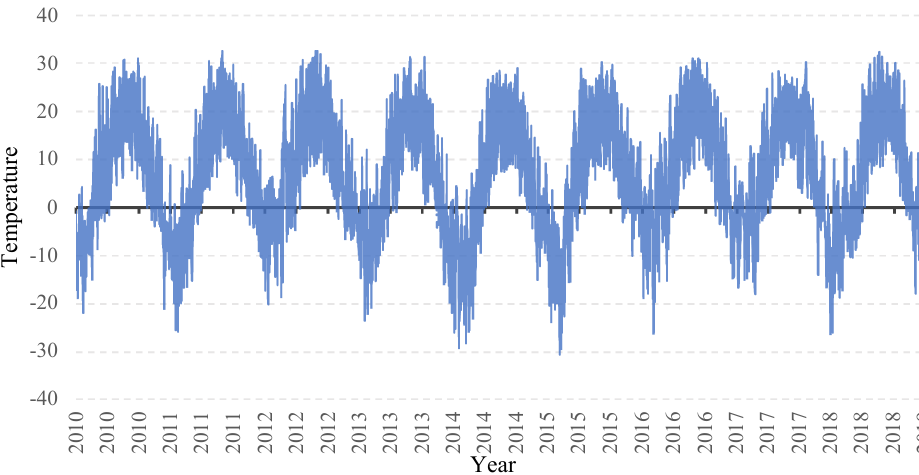
Figure 4. Temperature trend in training set data.